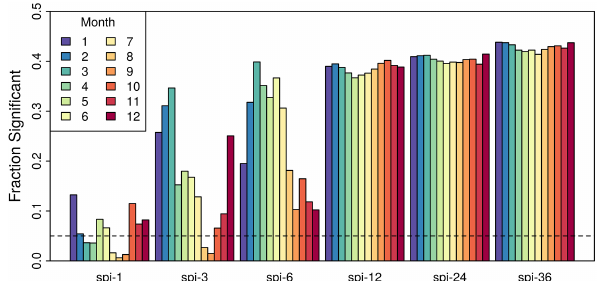
Figure 1. Fraction of grid-cells with significant ( α local < 0.05) trends in SPI- τ , where τ refers to the time-scale. Trends are eval- uated for each calendar month separately. Field-significance is de- clared only if the fraction of significant grid-cells is larger than 0.05 ( α global ≤ 0 . 05, horizontal dashed line). See text for